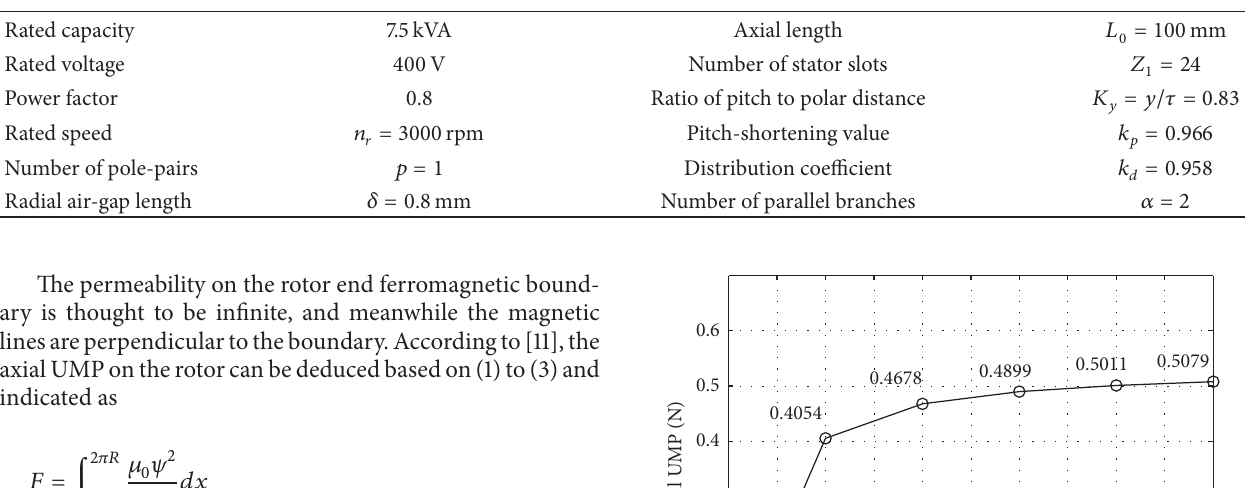
Table 2: Primary parameters of SDF-9 type generator.